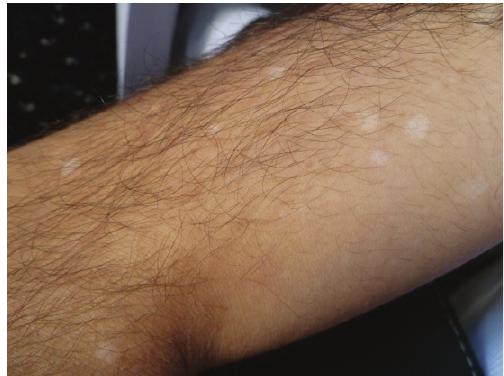
Figure 1: Vitiligo lesions on the upper arm of